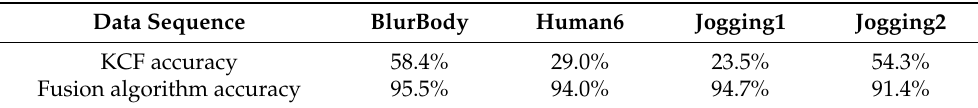
Table 4. Experimental comparison of re-recognition fusion algorithms.